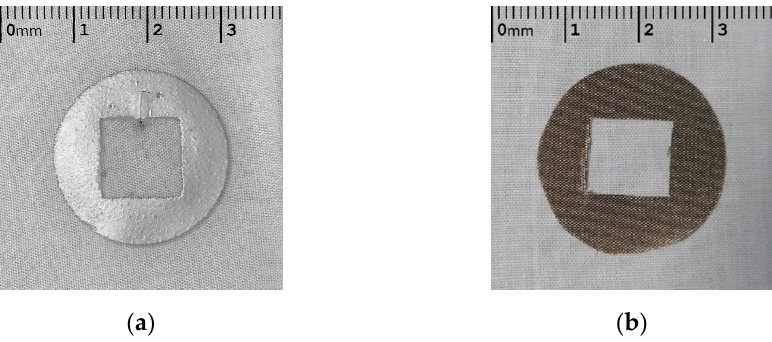
Figure 4. Textile based EPS electrodes, silver conductive ink ( a ) and conductive textile ( b ).